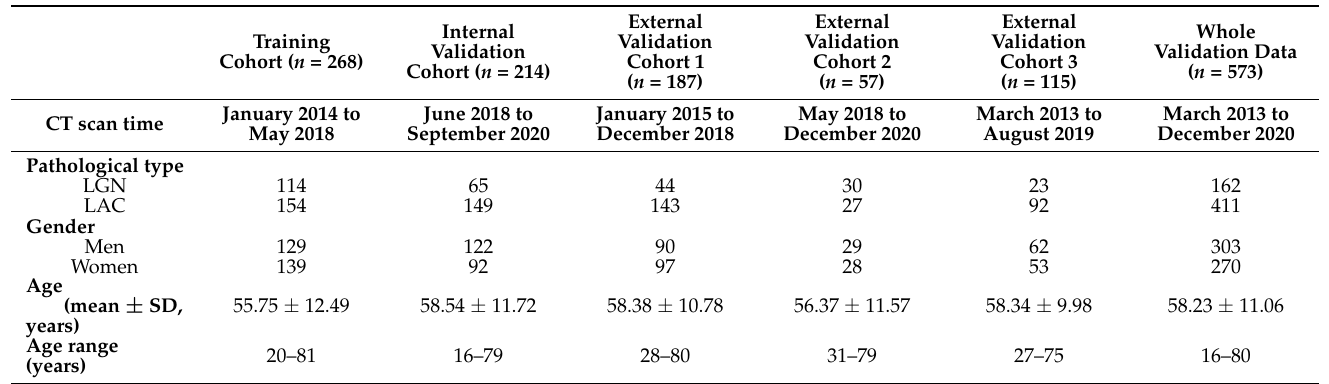
Table 1. Basic information of patients enrolled in the